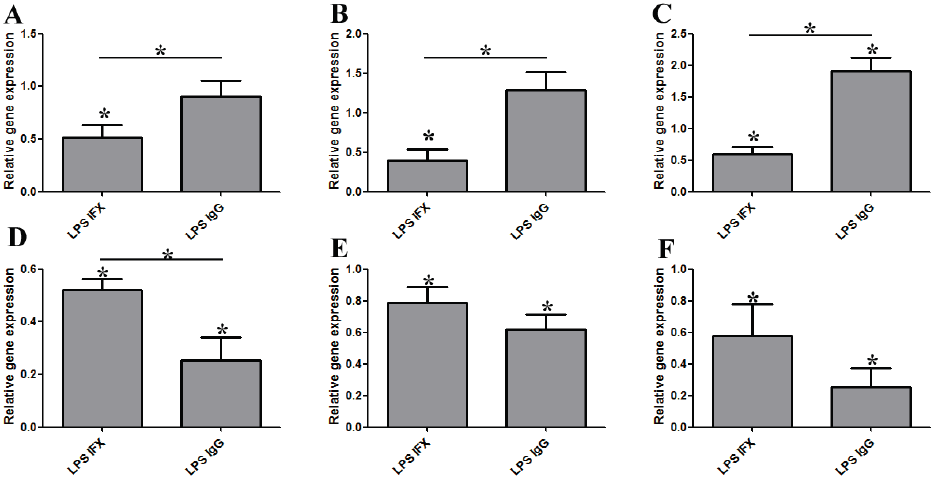
Figure 6. The effect of IFX on LPS-challenged primary mouse macrophages. Macrophages were activated by the presence of LPS before IFX treatment. Relative gene expression of TNF ( A ), IL-6 ( B ), PDCD1 ( C ), CXCL9 ( D ), CXCL10 ( E ), and ICAM-1 ( F ) was determined by qRT-PCR. LPS- and IgG-treated, as well as only LPS-stimulated, samples were used as controls. Bars show average ± SEM from at least three independent experiments. * Significantly different (One-Way ANOVA, Neuman–Keuls post hoc